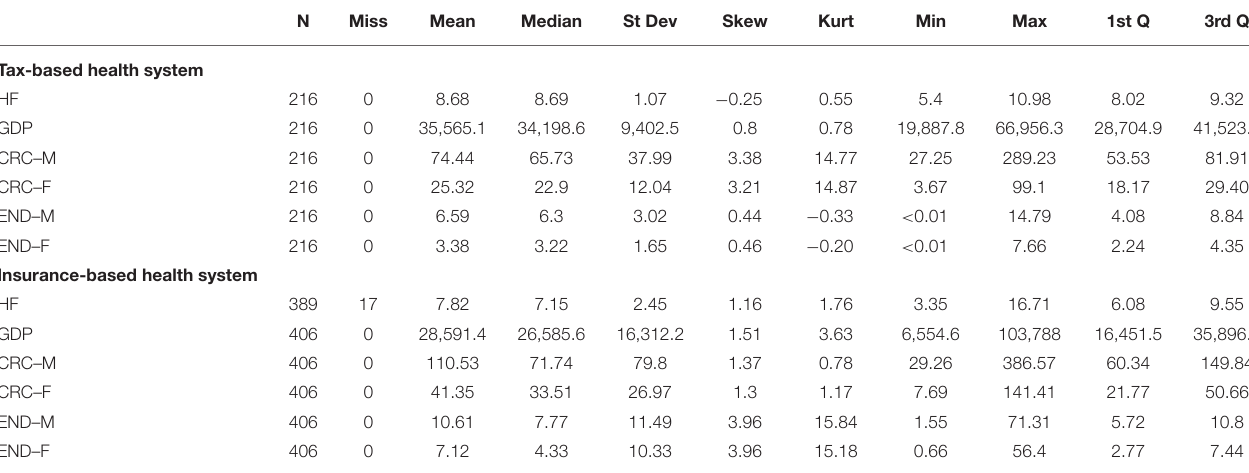
TABLE 1 | Descriptive statistic of economic and health variables classified by health systems and gender